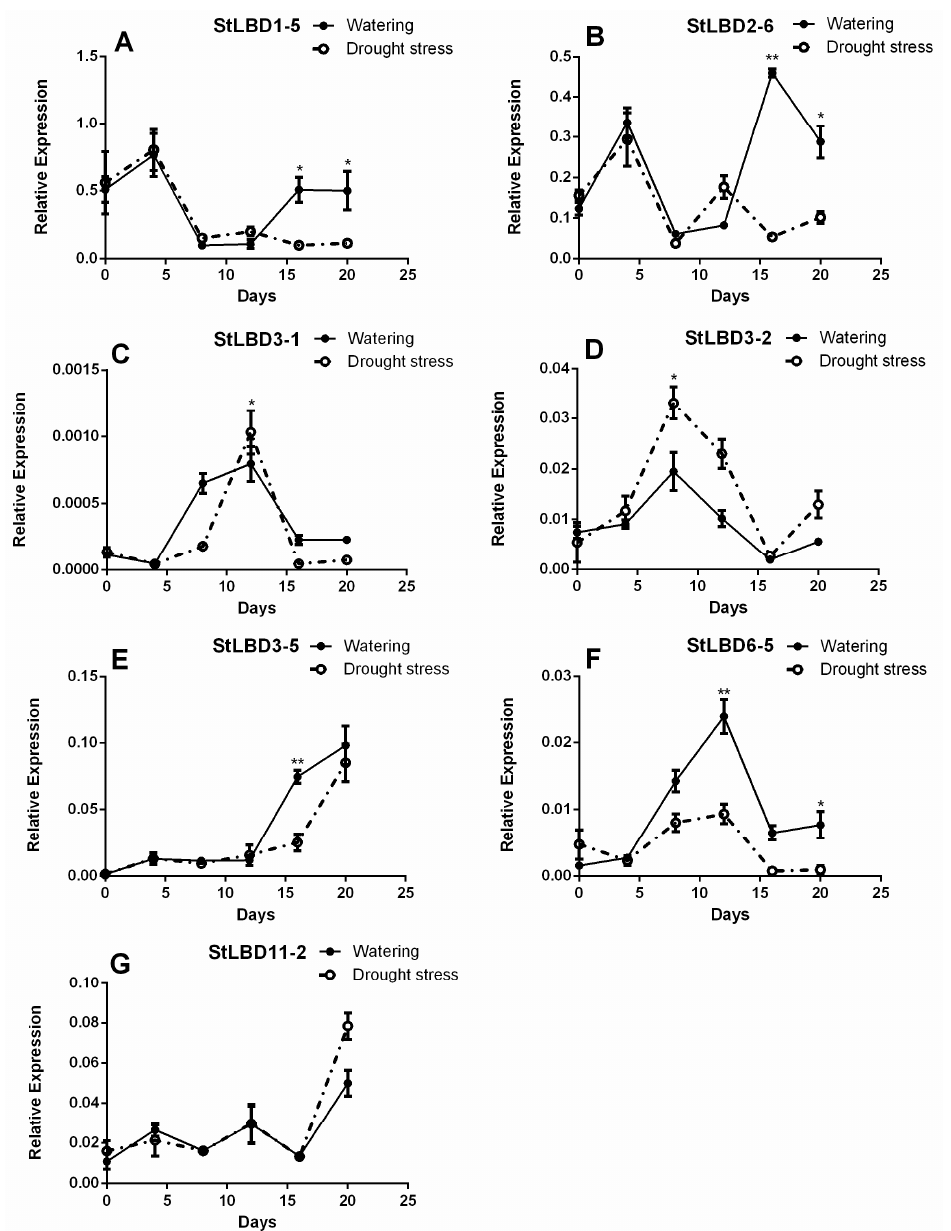
Figure 9. Curve of expression of the StLBD gene with time under drought stress and normal watering treatment. Asterisks indicate significant differences using Student’s t test (* p < 0.05; ** p < 0.01).